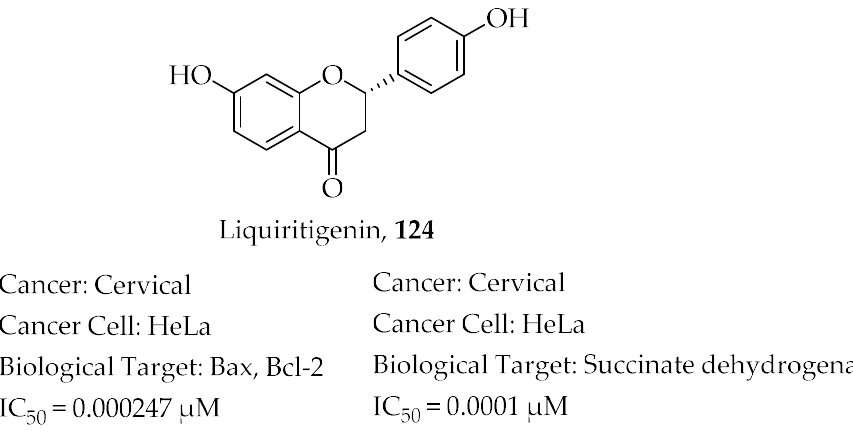
Figure 20. Structure of the dihydroxyflovanone Liquiritigenin with a summary of its biological activity towards selected cancer targets.